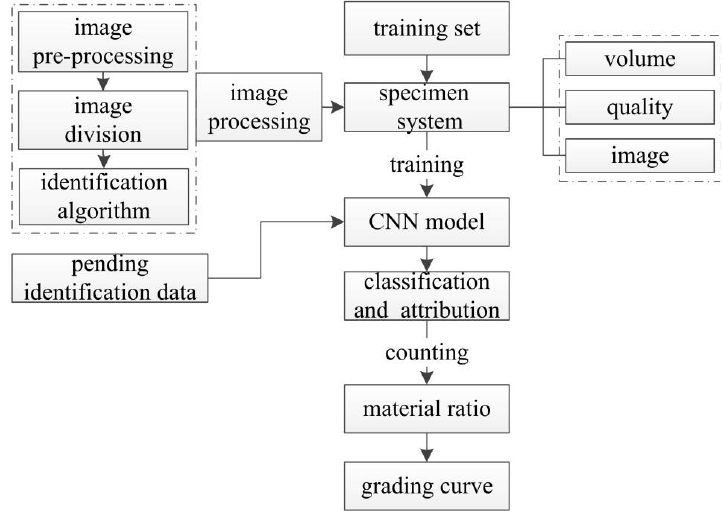
Figure 10. Flowchart of the online detection and identification of the aggregate gradation in the cemented sand and gravel.